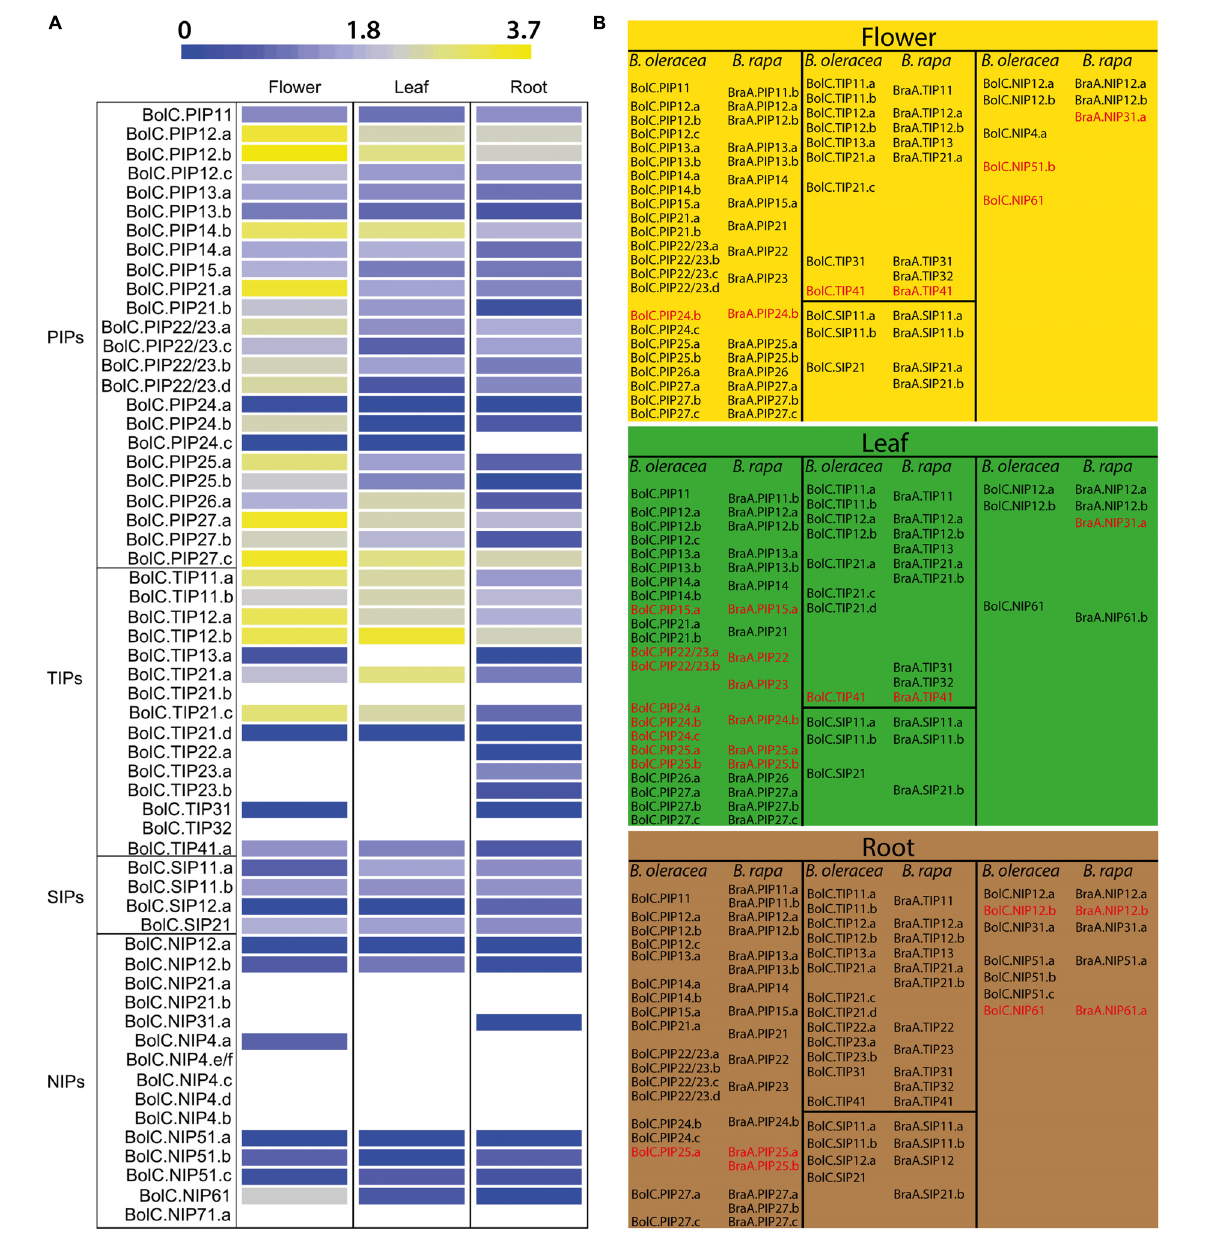
oleracea and B. rapa AQP genes to flower, leaf, or root organs based on their expression values. Genes with similar expression patterns than their homologs from A. thaliana are depicted in black. Genes with significant expression in other organs than reported for A. thaliana homologs are depicted in